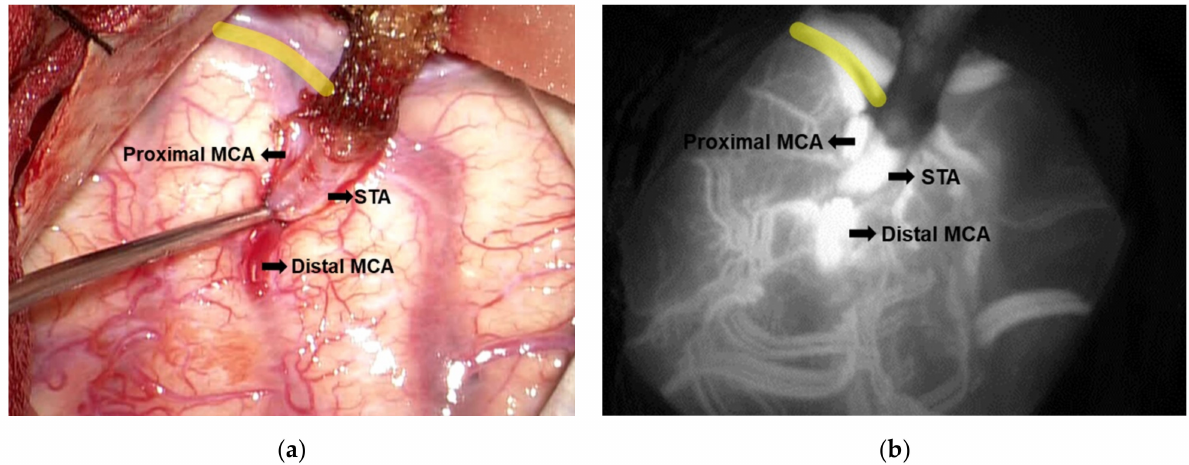
Figure 2. Anastomosis site of the superficial temporal artery- middle cerebral artery (STA-MCA) bypass. ( a ) The gross appearance shows the completed micro-anastomosis between STA and MCA. ( b ) The patency of the anastomosis site as confirmed by indocyanine green angiography. Yellow lines indicate the sylvian fissure. STA, superficial temporal artery; MCA, middle cerebral